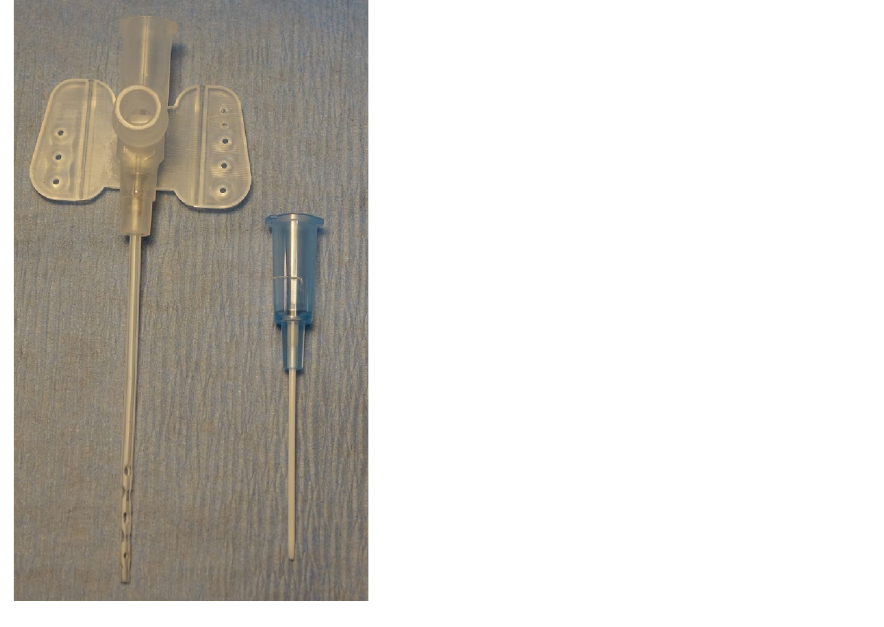
Figure 5. Venous and arterial ECMO cannula. The modified multi-orifice 17 G cannula (1.5 mm, B. Braun, cannula with white connector) was inserted into the internal jugular vein and carefully moved into the right atrium for venous drainage. The oxygenated blood from the ECMO was returned to the femoral artery via a 22 G catheter (0.9 mm, Terumo, cannula with blue